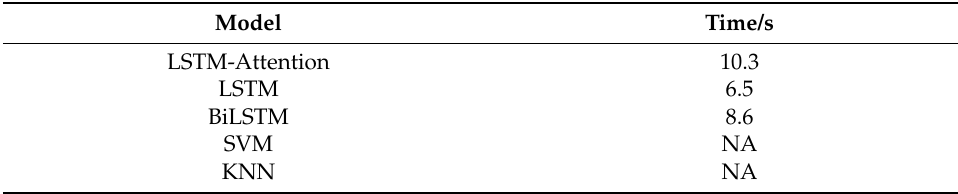
Table 8. Training time for one epoch of different